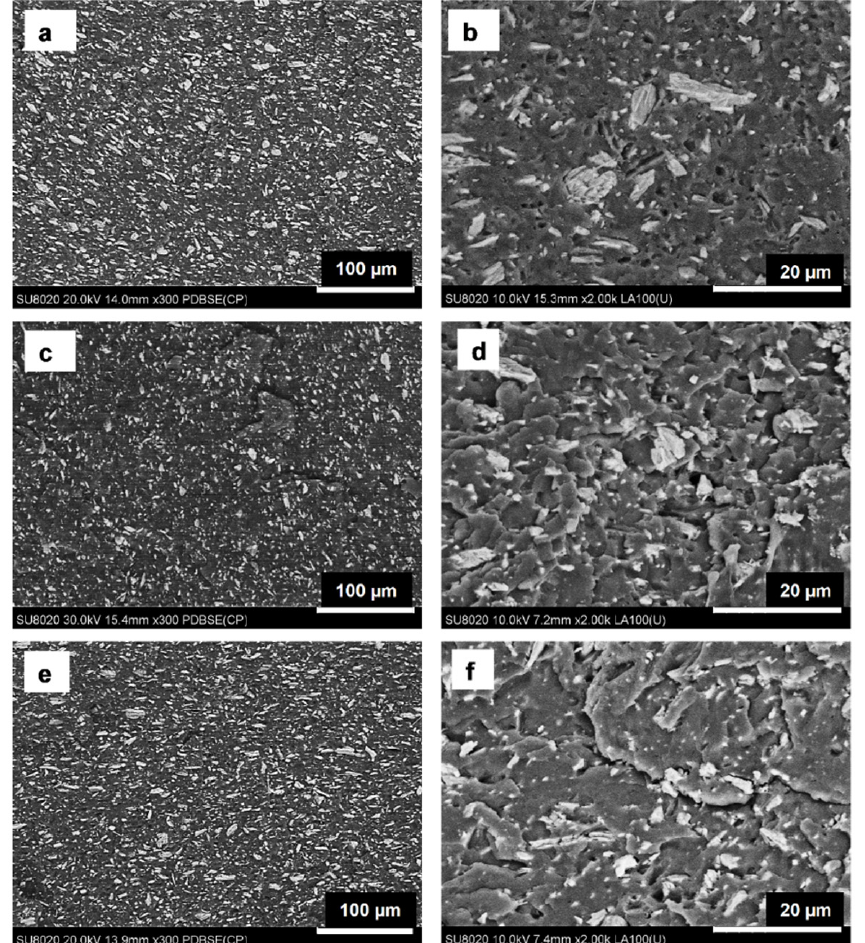
Figure 5. ( a – f ) SEM pictures (BSE) at different magnifications on the cryofractured surfaces of ( a , b ) unplasticized PLA–AII, ( c , d ) PLA–AII–10TBC and ( e , f ) PLA–AII–15TBC plasticized composites.